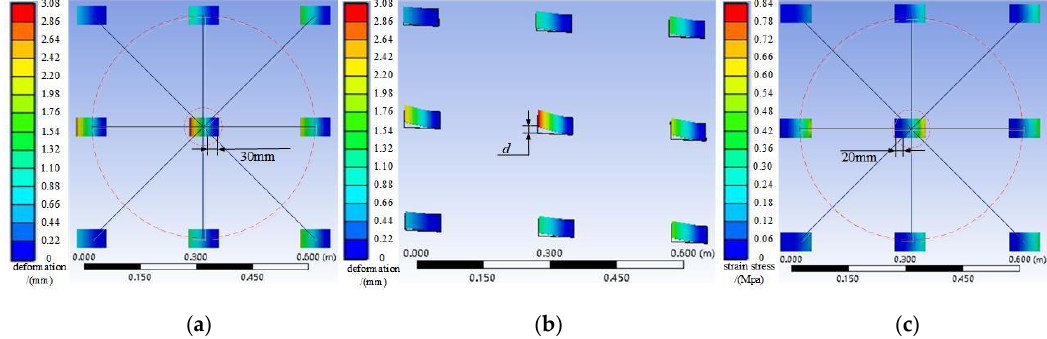
Figure 6. Deformation and strain cloud diagram of a flexible detection structure after flow field action. ( a ) Shape variable cloud; ( b ) Shape change cloud; ( c ) Strain cloud.